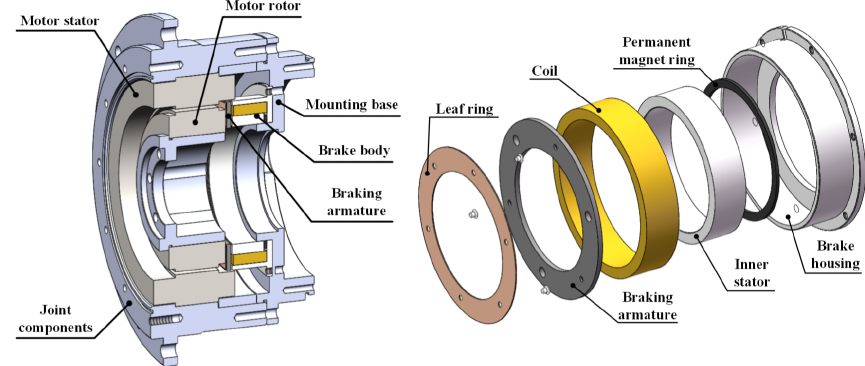
Figure 1. 3D model of the brake.